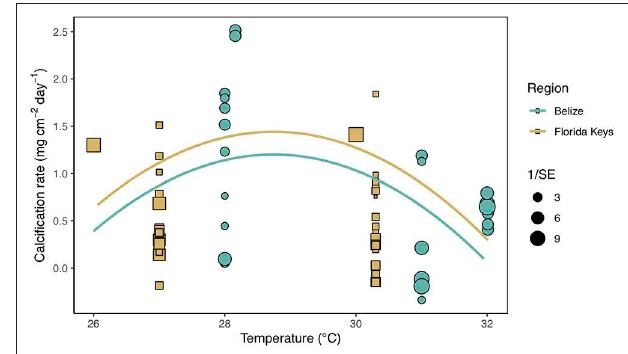
FIGURE 4 | Mean calcification rate (mg cm − 2 day − 1 ) of corals from each warming study by treatment temperature ( ◦ C) with the linear mixed effects model quadratic fit by region and experimental duration (mean duration = 59.8 days). Shape and color of each point denotes study region (blue circle = Belize; brown square = Florida) and size of shape represents the weight (1/SE) of study.